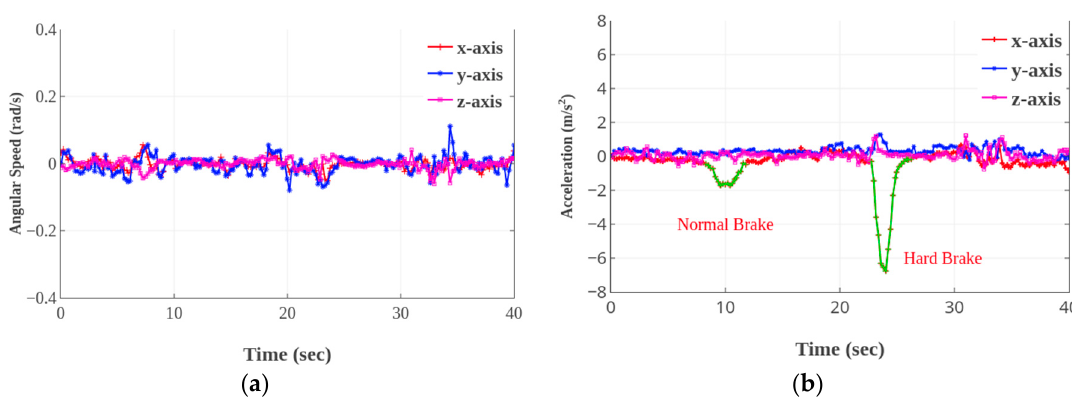
Figure 7. Patterns of brake, angular speed ( a ); acceleration ( b ).